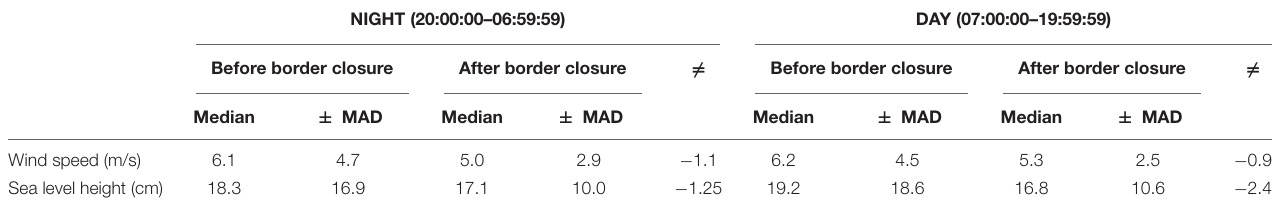
FIGURE 4 | Plots showing the variability in the shipping noise indicators [63–125 Hz TOB sound pressure levels (dB re 1 µ Pa)], the 100–10,000 Hz TOB sound pressure levels that are more impacted by wind speed (dB re 1 µ Pa) (Wenz, 1962), wind speed (m/s), and sea level height (cm) between 29 January and 26 May 2020 at the Tisler cold-water coral reef. The brown and grey lines shows the actual data. The black line is a LOESS fitted curve to make the comparison of the trends more intuitive. TABLE 5 | The median and the mean absolute deviation (MAD) of the wind speed and sea level height at the Tisler reef downloaded from